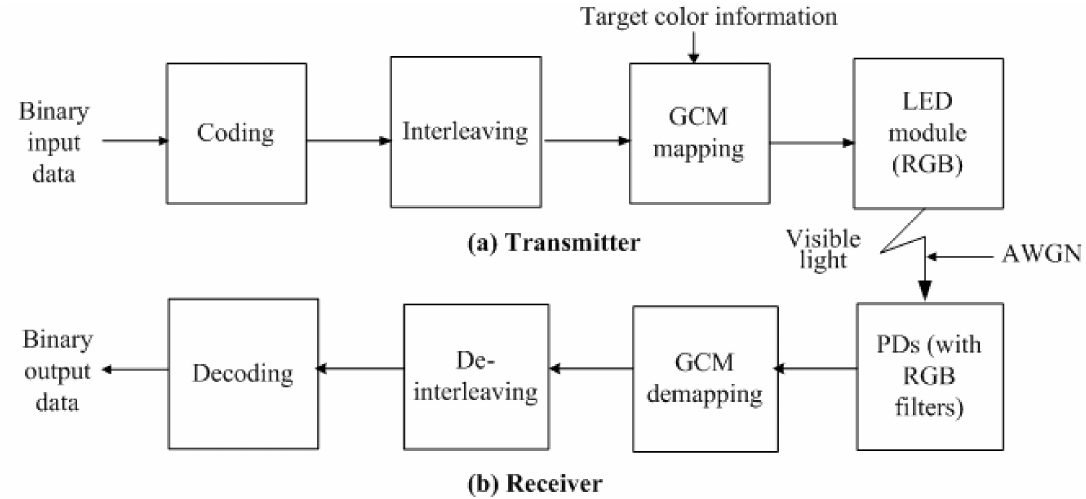
Figure 6. Simple simulation model used to demonstrate the proposed generalized color modulation (GCM)-based VLC system